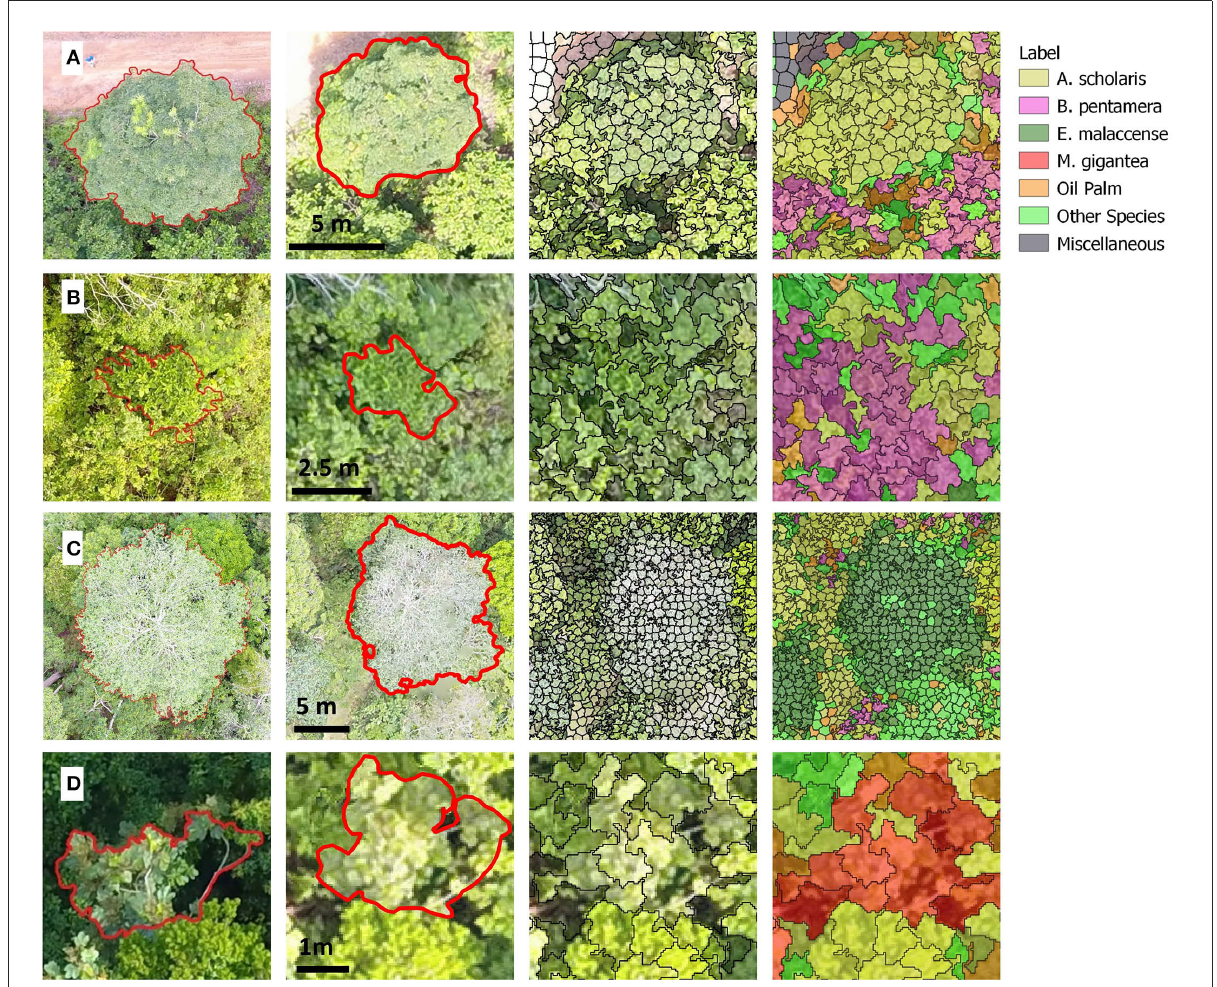
FIGURE5 Example images of complete pipeline for the main four species recorded in the field. Each row includes imagery of one crown: (A) Alstonia scholaris , (B) Bellucia pentamera , (C) Endospermum malaccense , and (D) Macaranga gigantea . Across the columns (left to right) are shown the manual flight image marked up in the field for crown extent, the outline converted to a shapefile overlain on the RGB orthomosaic, the SLIC superpixels laid over this orthomosaic and the labeling of these superpixels using the SVM approach for the model with all categories. We have only included the outline and labeling for the crown in the center of each image, but the columns with superpixels are taken from the full landscape map to show this crown in context and so include labels on other superpixels. Note that each row has a different scale as indicated by the scale bars. The purpose of this is to show the tree and its immediate surroundings in sufficient